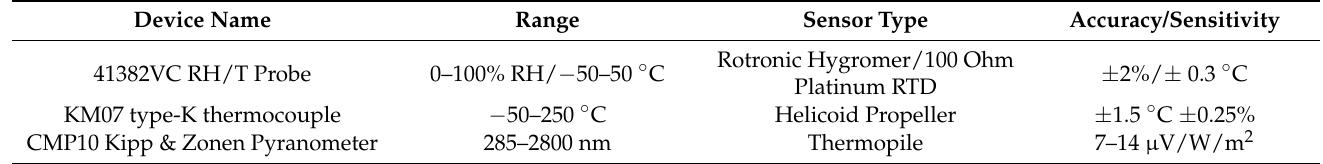
Table 2. Specification of the sensors used for measuring meteorological data and water temperature of the solar water heater. Device